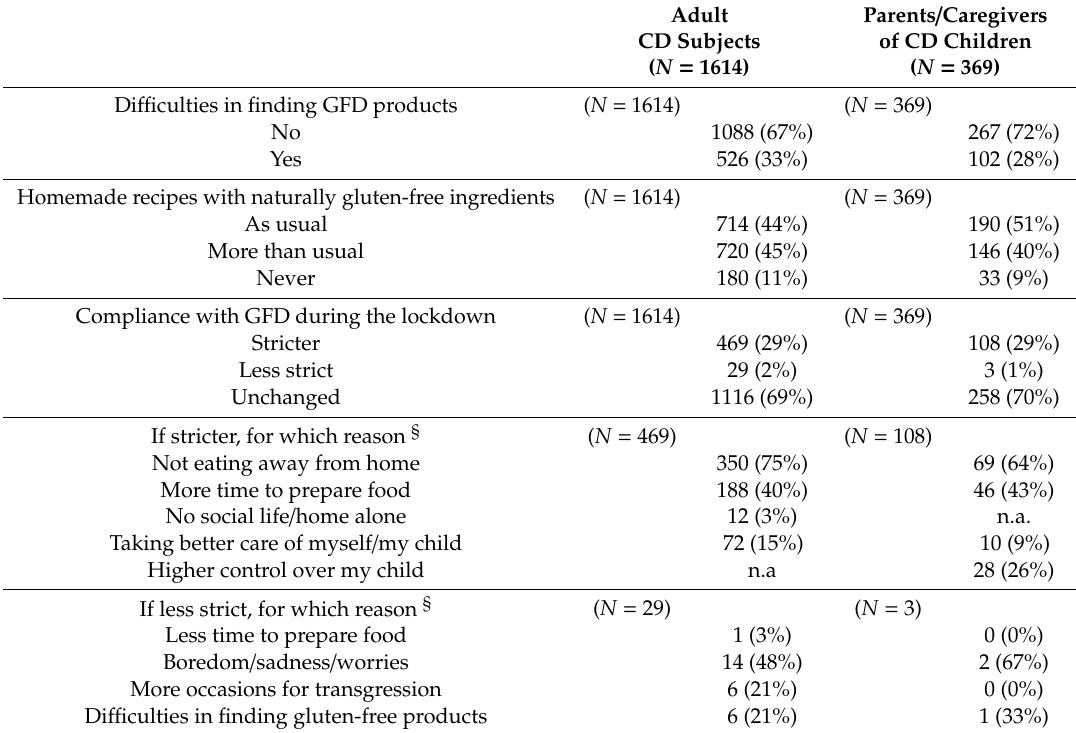
Table 3. Data about GFD during the